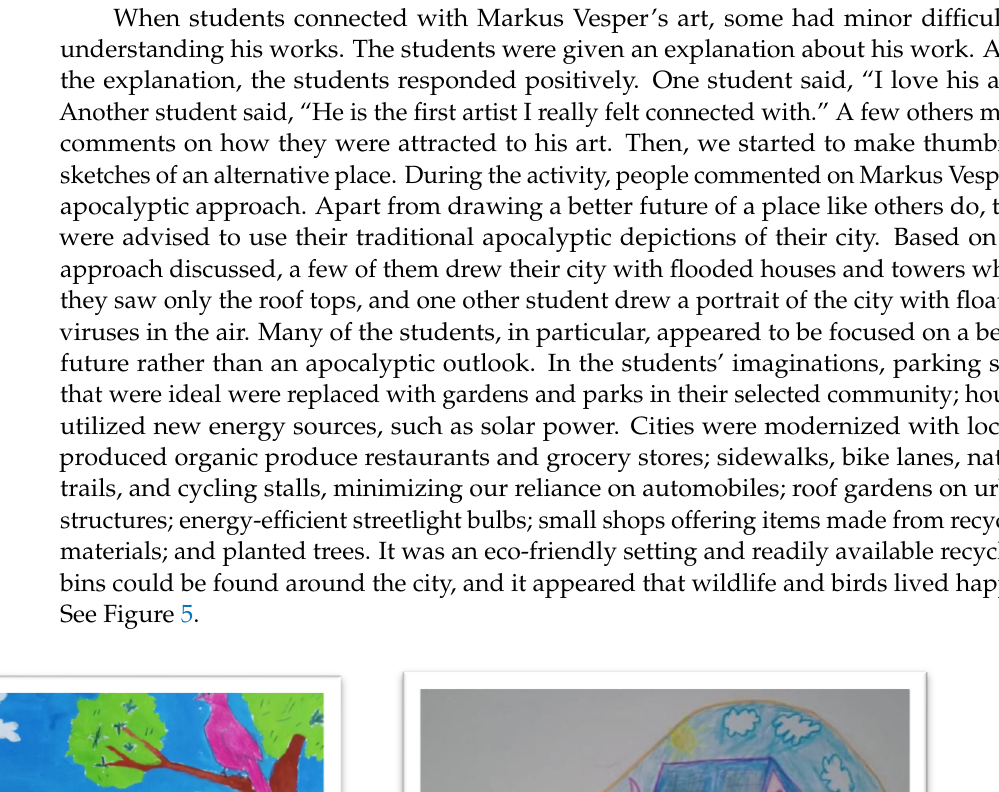
Figure 5. Picture of students’ special place.